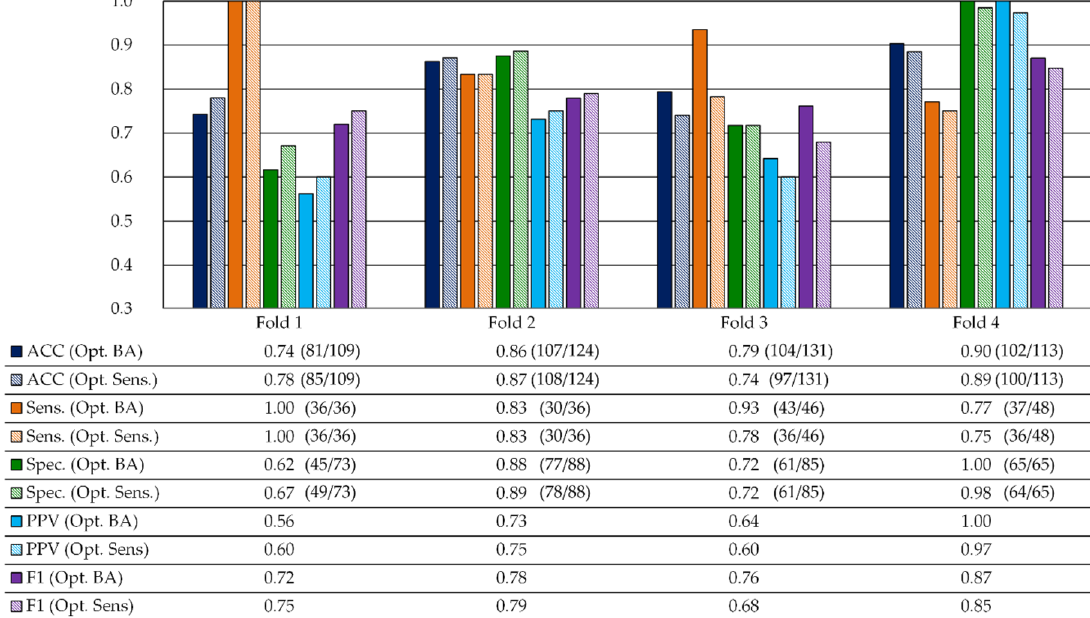
Figure 13. Average image classification results per patient in the test set using the SVM Linear kernel optimized with the BA metric. P9 to P13 only have samples from tumor class. Table 2 shows the results of the proposed superpixel approach (reporting both the results at image and superpixel level) and the previous work, where the same data were classified using a patch-based CNN approach (reporting the results at patch level) [10]. As shown in Table 2, data from